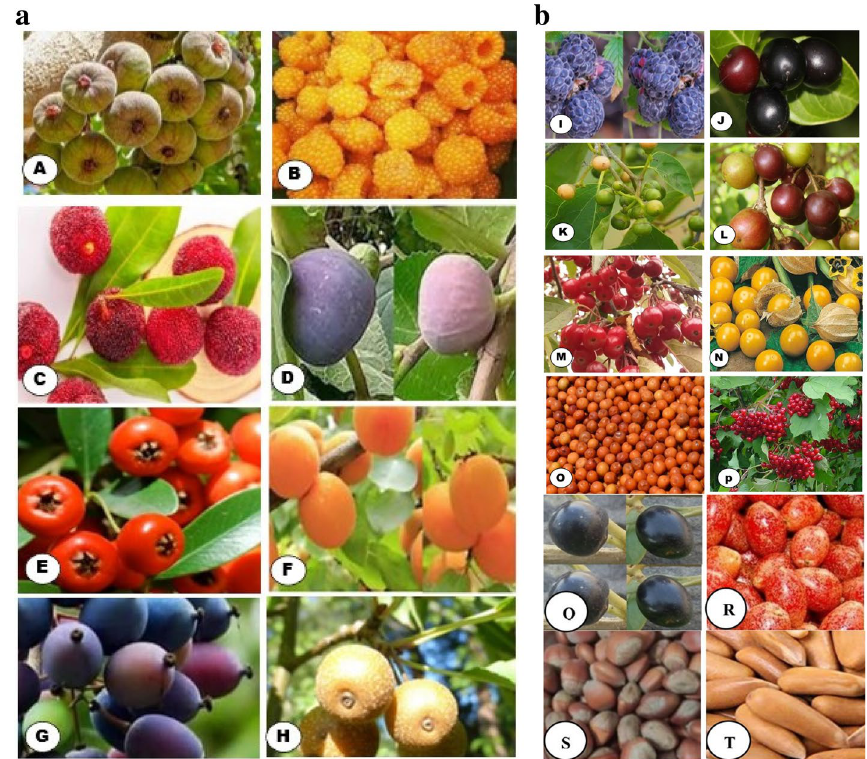
Fig. 1 a Images of important underutilized fruits of the northern Himalayas (A) Ficus auriculata , (B) Rubus ellipticus , (C) Myrica esculenta, (D) Ficus palmata , (E) Pyracantha crenulate, (F) Prunus armeniaca , (G) Berberis asiatiica and (H) Pyrus pashia. b Images of important underutilized fruits of the northern Himalayas (I) Rubus niveus , (J) Carissa spinarum, (K) Cordia dichotoma (L) Flacourtia indica , (M) Malus sikkimensis , (N) Physalis peruviana , (O) Ziziphus mauritiana and (P) Viburnum mullahaa (Q) Olea ferruginea , (R) Elaeagnus latifolia, (S) Corylus jacquemontii, and (T) Pinus